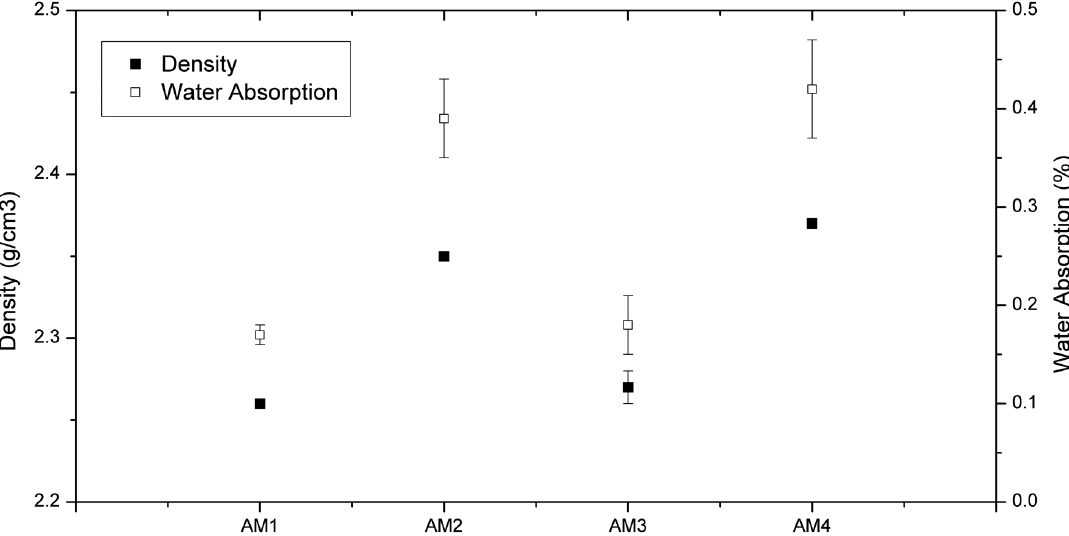
Figure 2. Average values for density and water absorption of produced artificial marbles (AM1, AM2, AM3, AM4). Mean + standard error.